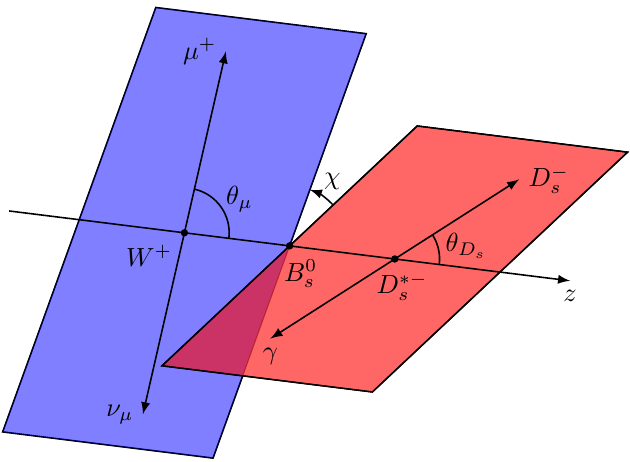
Figure 1 . Schematic overview of the B 0